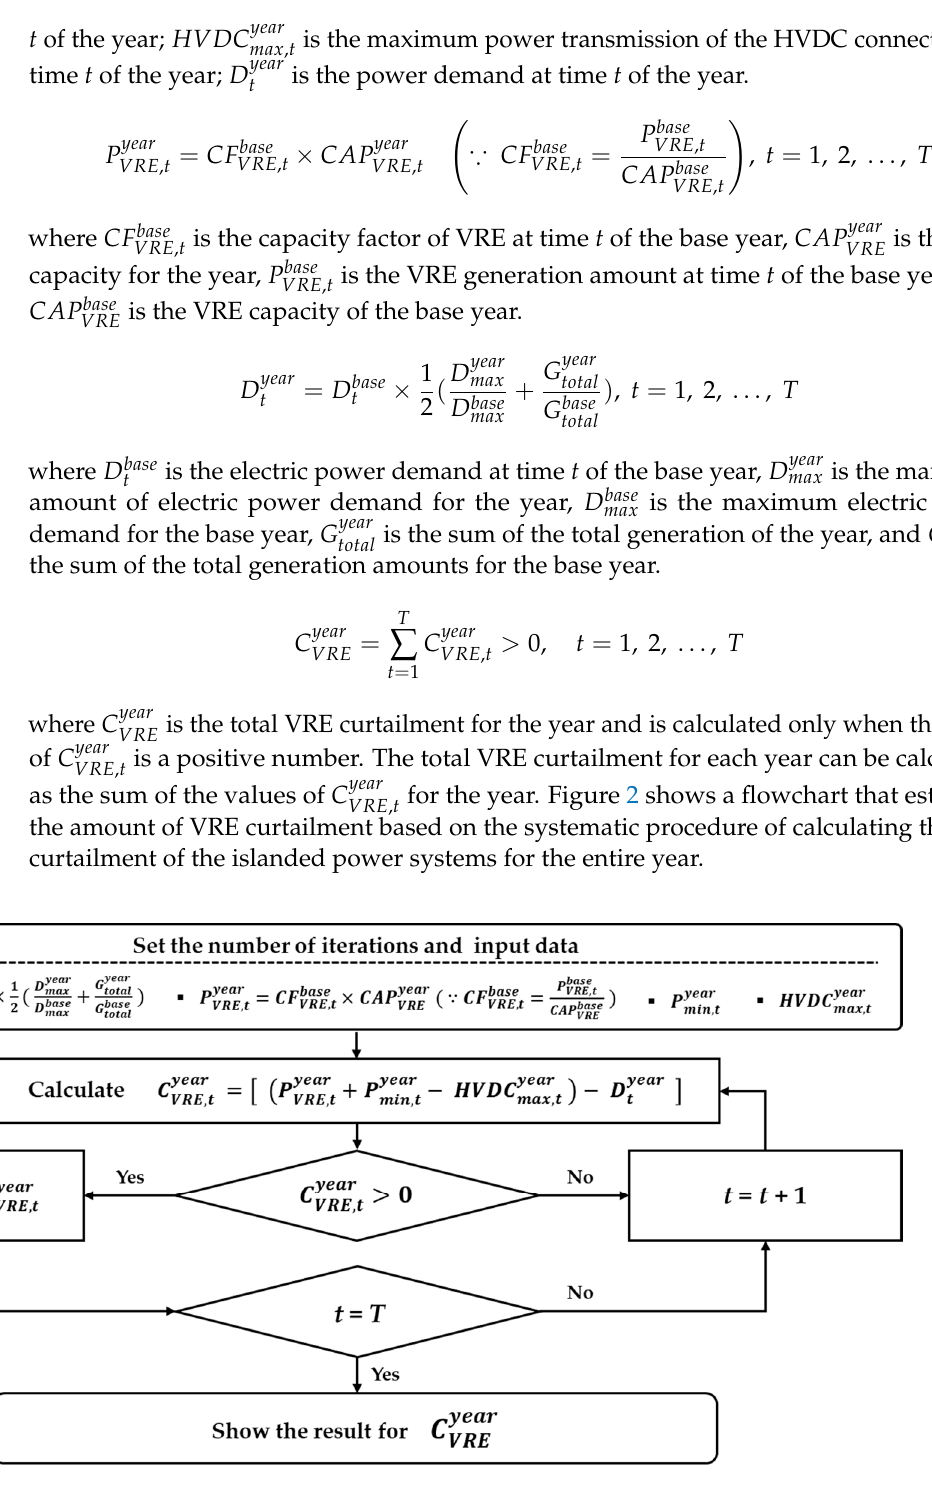
Figure 2. Flowchart of the long-term estimation of the amount of variable renewable energy (VRE) curtailment.